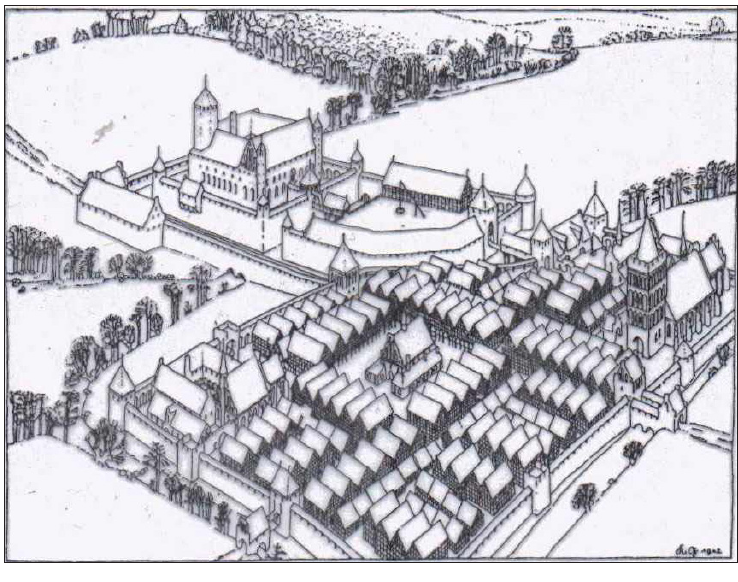
Figure 2: The medieval castle and cathedral surrounded by timber structure dwellings Source: Frampton, 2001: